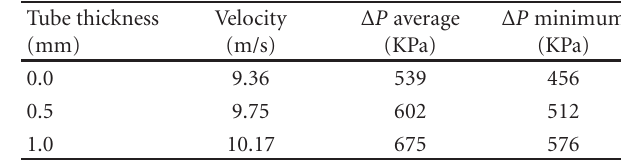
Table 3: Atucha pressure drop channel for average misalignment or fully aligned FEs, predicted for ten CANDU fuels assembled by means of a circumferential